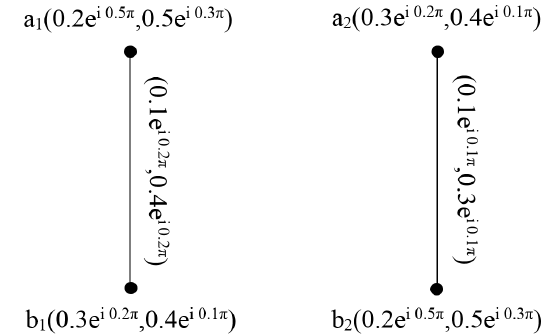
Figure 11. Complex intuitionistic fuzzy graphs of G 1 and G 2